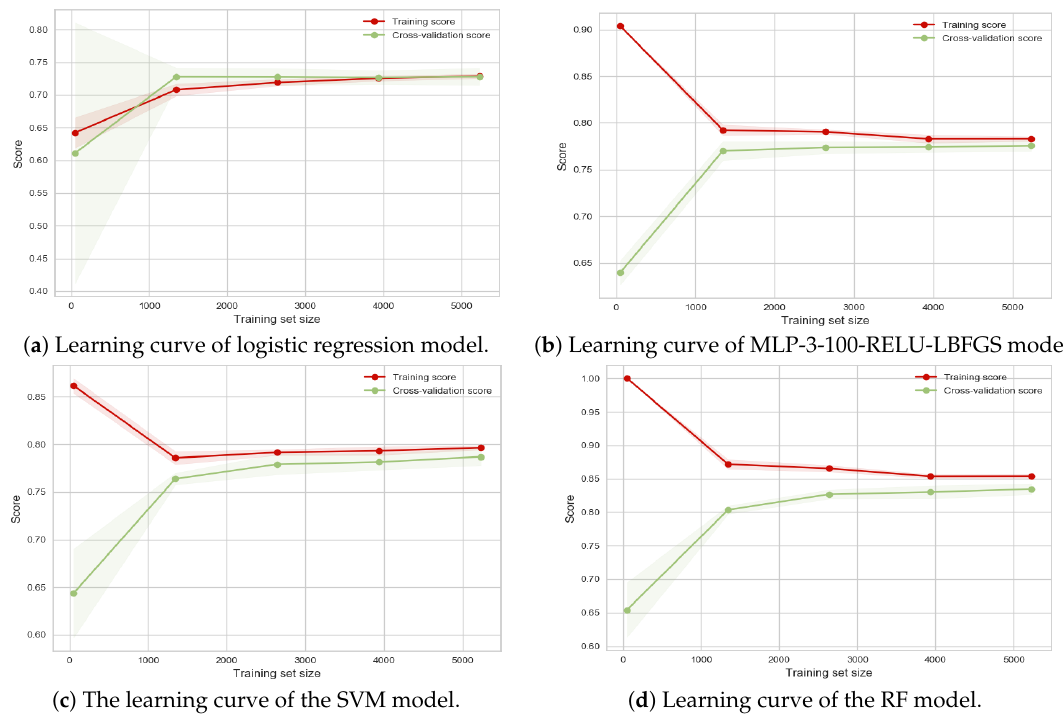
( c ) The learning curve of the SVM model. Figure 9. Learning curve of machine learning models for